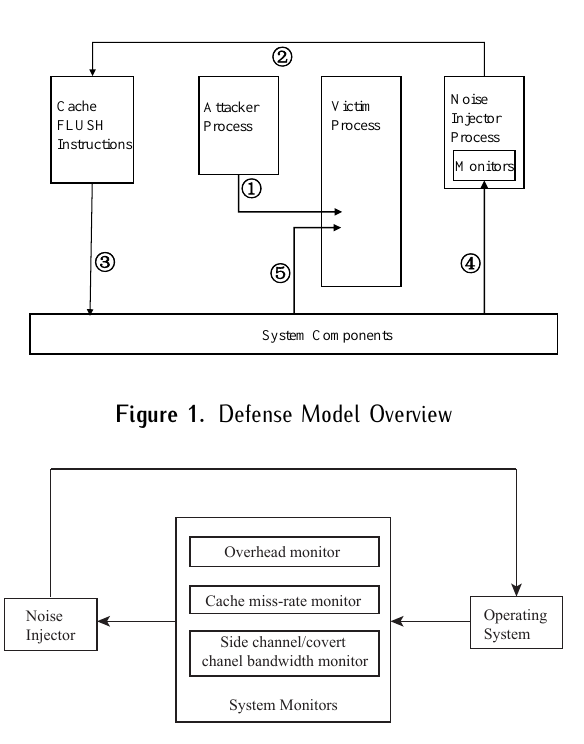
Figure 2. Adaptive Control Design with